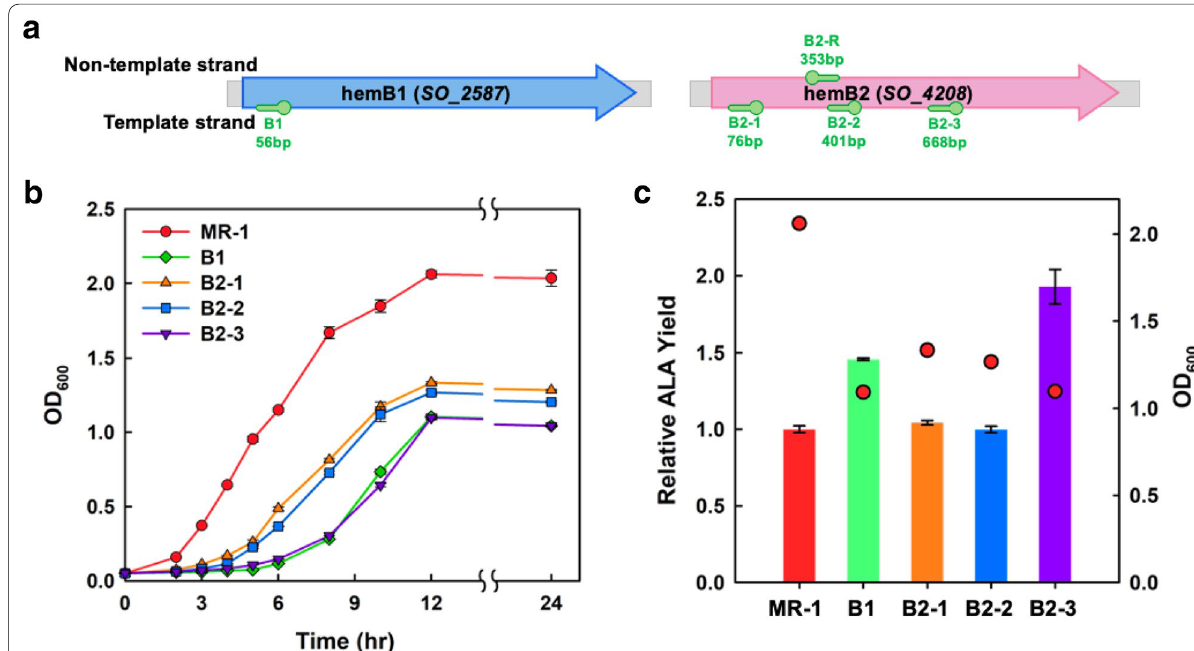
Fig. 4 Characterization of different targeting sites on hemB genes in MR‑1. a Several targeting sites for dCas9 were designed on hem B2 ( SO_4208 ). The growth curve ( b ) and relative ALA yield ( c ) were analyzed from the strains in LB medium at 12 h. The bar in c shows the relative ALA yield compared with that in wild‑type MR‑1. Red dots indicate the OD 600 of